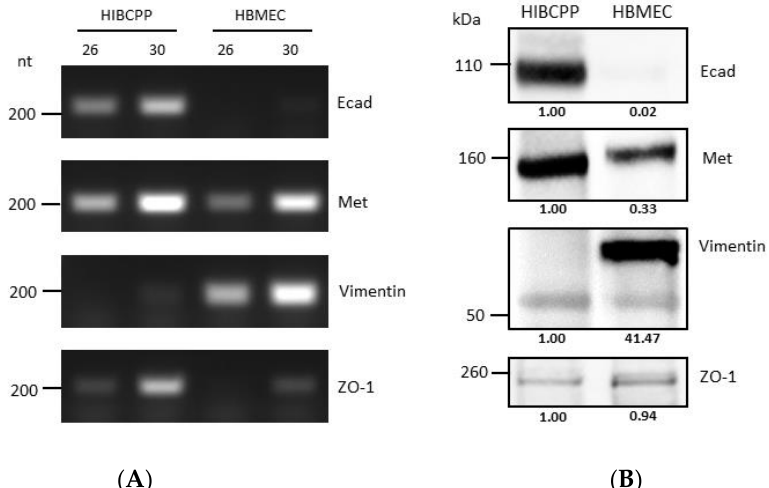
Figure 1. Differences in molecular expression patterns of VF target proteins between HIBCPP cells and HBMEC. ( A ) Transcription levels of genes of interest in HIBCPP cells and HBMEC, as obtained through semi-quantitative PCR (numbers 26 and 30 denote the number of PCR cycles). Gene names are indicated at the right side of the panels ( B ) Analysis of the protein expression levels of proteins of interest in HIBCPP cells and HBMEC via western blotting. Gene names are indicated at the right side of the panels. The presented data were selected as representative of the average outcome of multiple performed